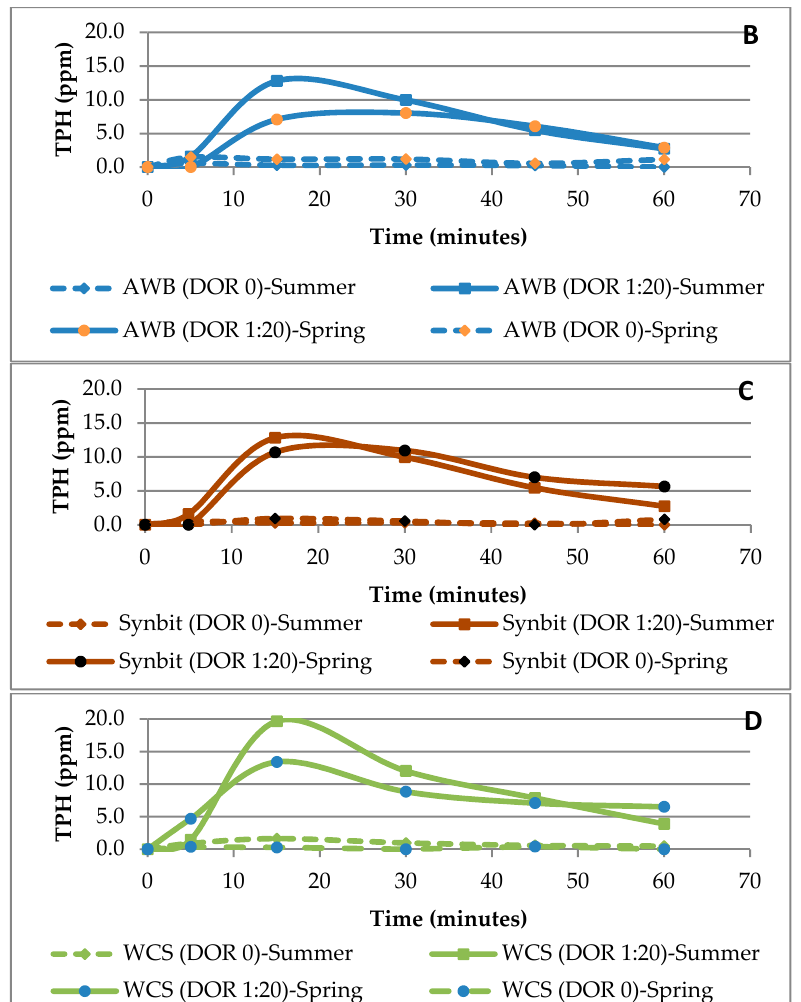
Figure 4. Average total petroleum hydrocarbon (TPH) concentrations in the water column over a depth of 0.05 to 1.4 m located 12 m downstream from the oil release point for treated and untreated oils: ( A ) Heidrun, ( B ) AWB, ( C ) Synbit and ( D ) WCS under spring and summer conditions. TPH concentrations were an order magnitude higher for oils treated with dispersant.